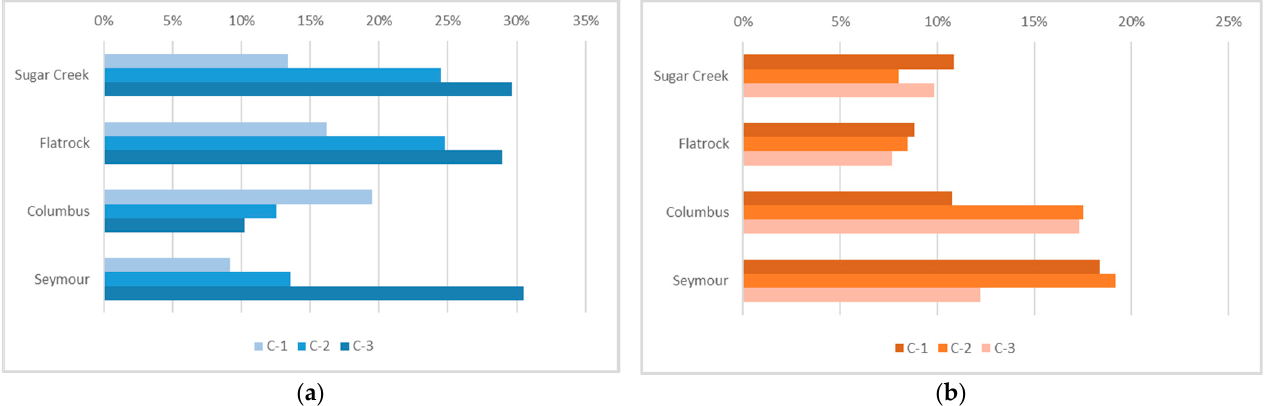
Figure 11. Water balance ratios for each of the upstream drainage areas and per configuration period for ( a ) surface runoff/precipitation and ( b ) percolation/precipitation.